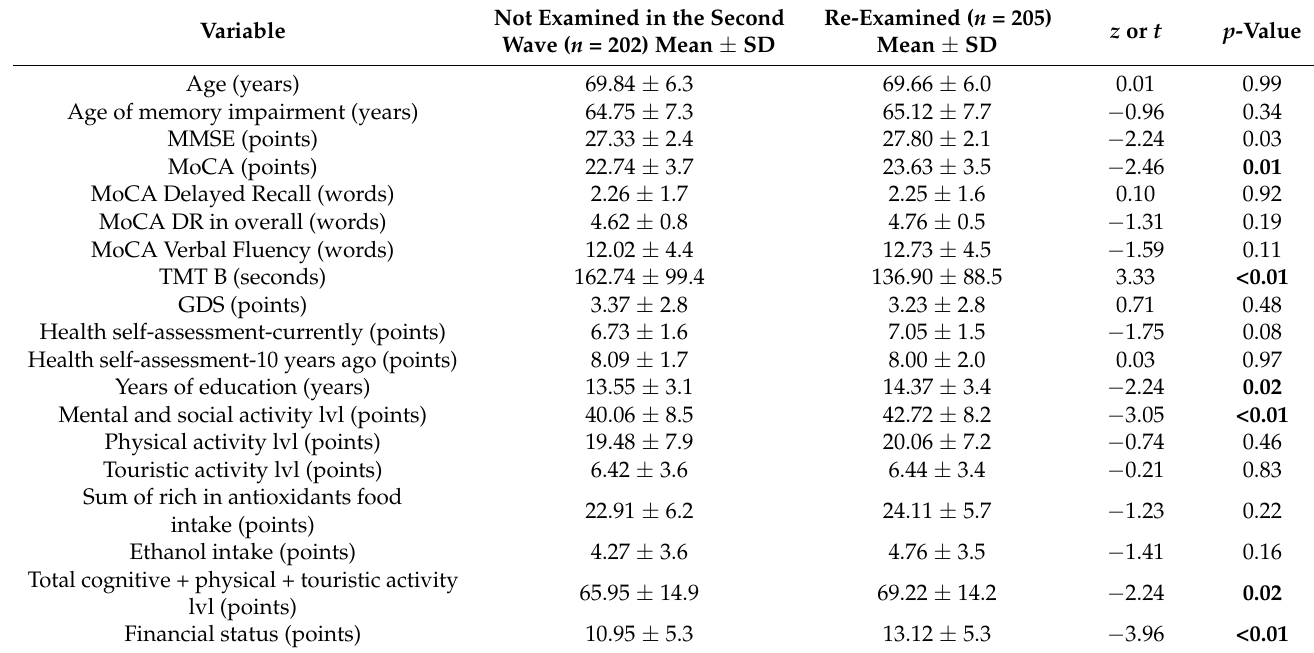
Table 1. Comparison of lost to follow-up vs. re-examined